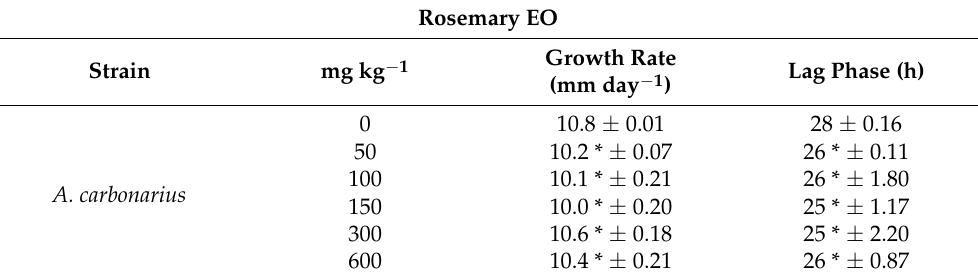
* Mean values ± standard deviation, based on triplicated data, with significant differences according to the Dunnett test ( p < 0.05). The A. westerdijkiae growth rate using oregano EO ranged from 1.3 to 5.6 mm day − 1 and the lag phase was between 33 and 88 h (Table 5). The A. carbonarius growth rate was from 2.8 to 11.0 mm day − 1 and the lag phase was between 33 and 53 h (Table 5). In all